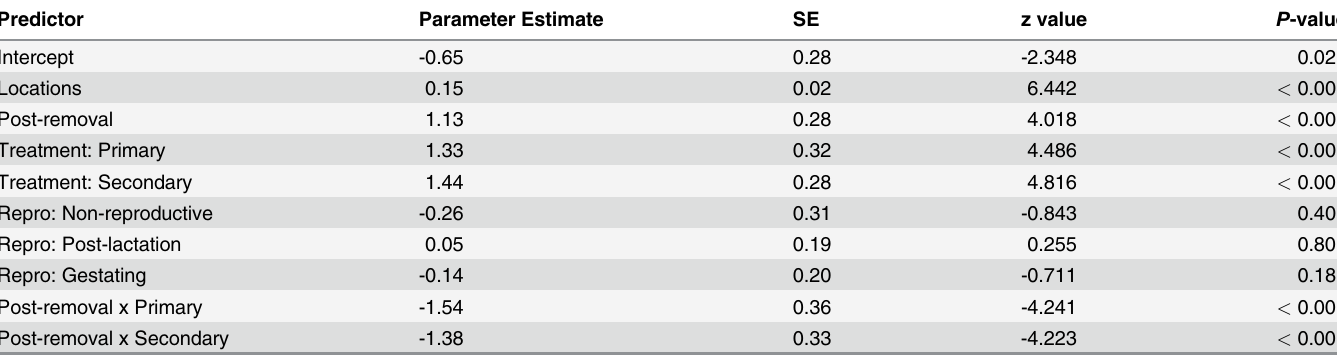
Table 2. Factors in fl uencing the number of roosts used by individual female northern long-eared bats.